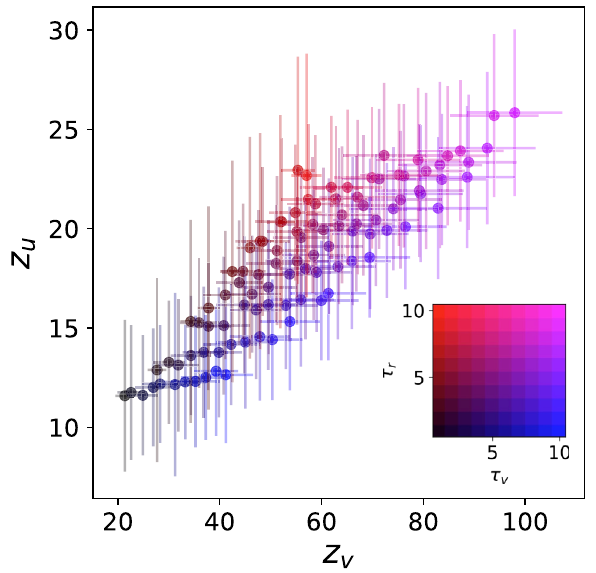
FIG. 6. The cell-cycle times τ and τ can be inferred from the r v half-decay lengths z and z , respectively, describing the distance v u over which volume and velocity drop to half their values at the front. The color of each point shows the value of τ and τ r v encoded into the simulations, see inset color map, while the position of the data point gives the different half-decay length combinations